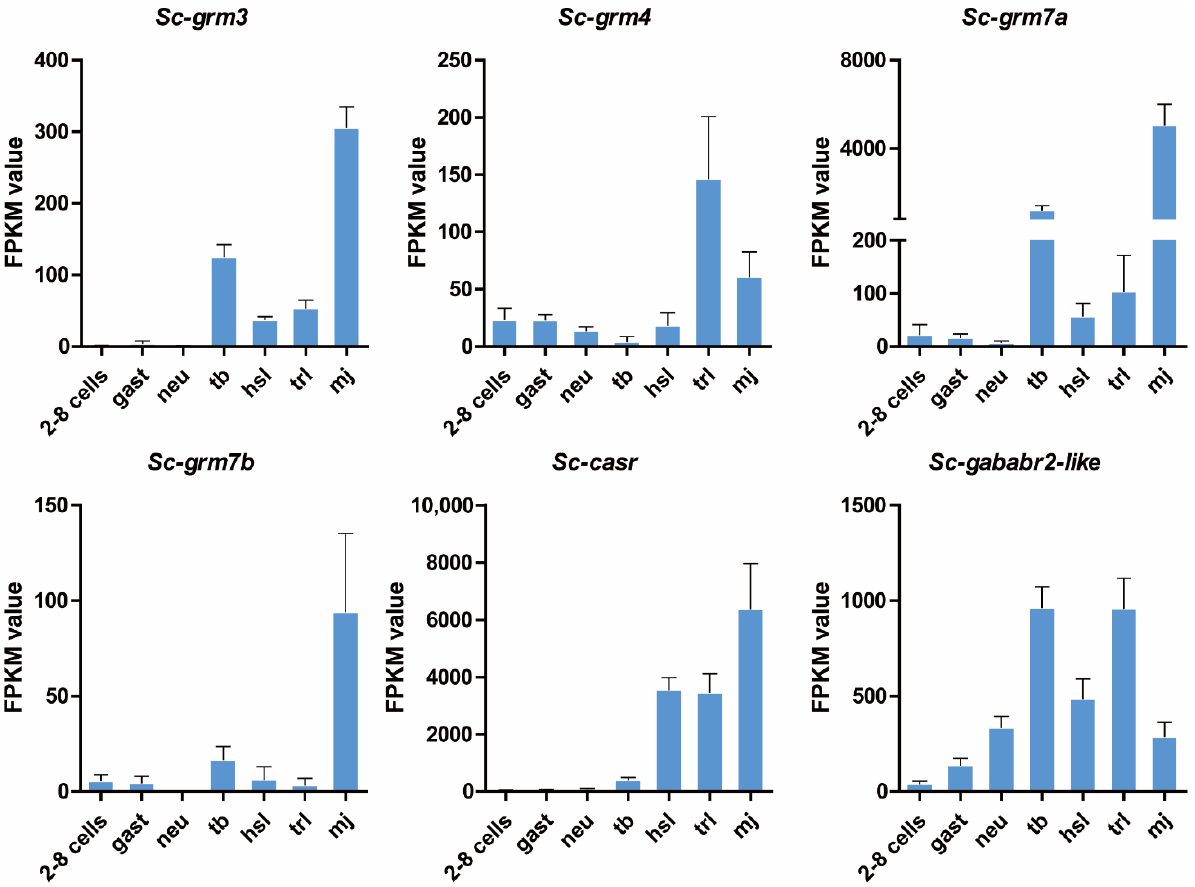
Figure 4. Expression pattern of S. clava Class C GPCRs during development. X-axis represents the seven developmental stages and Y-axis indicates the FPKM value analyzed from the transcriptome of S. clava [12]. Columns and bars represented the means and standard error of relative expression levels. Two-cell – eight-cell embryos (two to eight cells), gastrula embryos (gast), neurula embryos (neu), tailbud-stage embryos (tb), hatched swimming larvae (hsl), tail-regression larvae (trl), and metamorphic juveniles (mj).